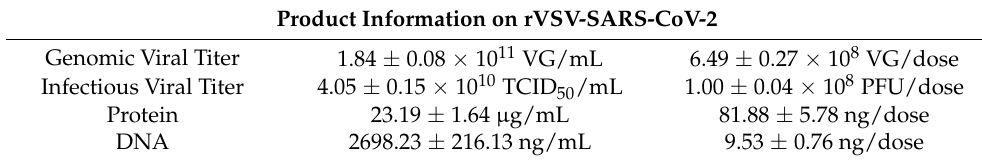
Table 2. Final product attributes for the rVSV-SARS-CoV-2